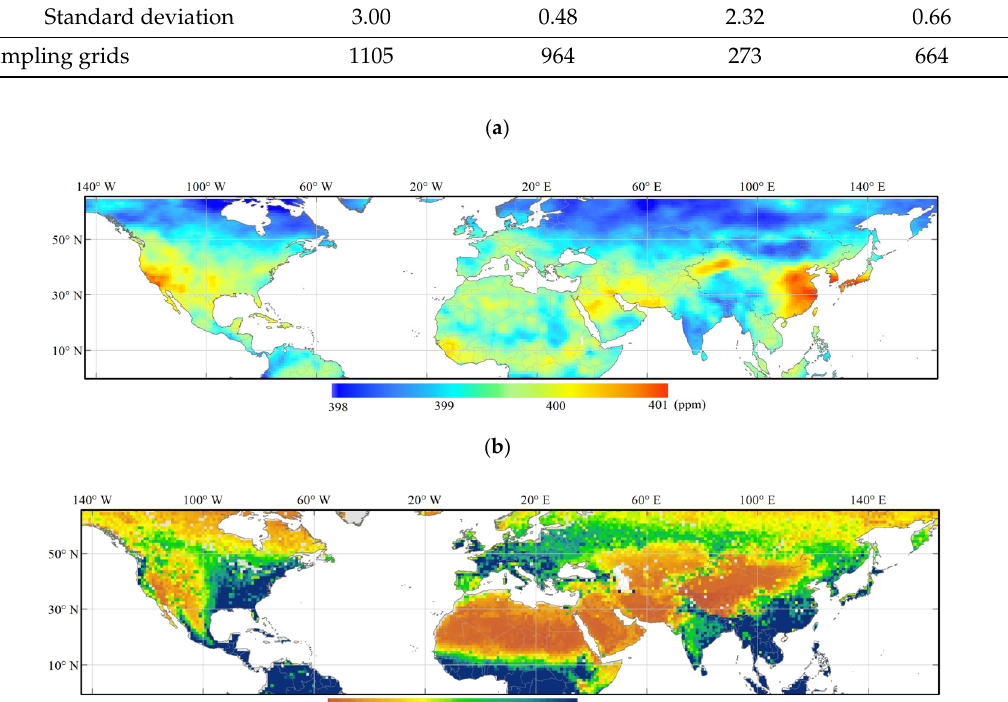
Figure A2. The gridded mean of ( a ) XCO 2 and ( b ) SIF in the Northern Hemisphere from April 2009